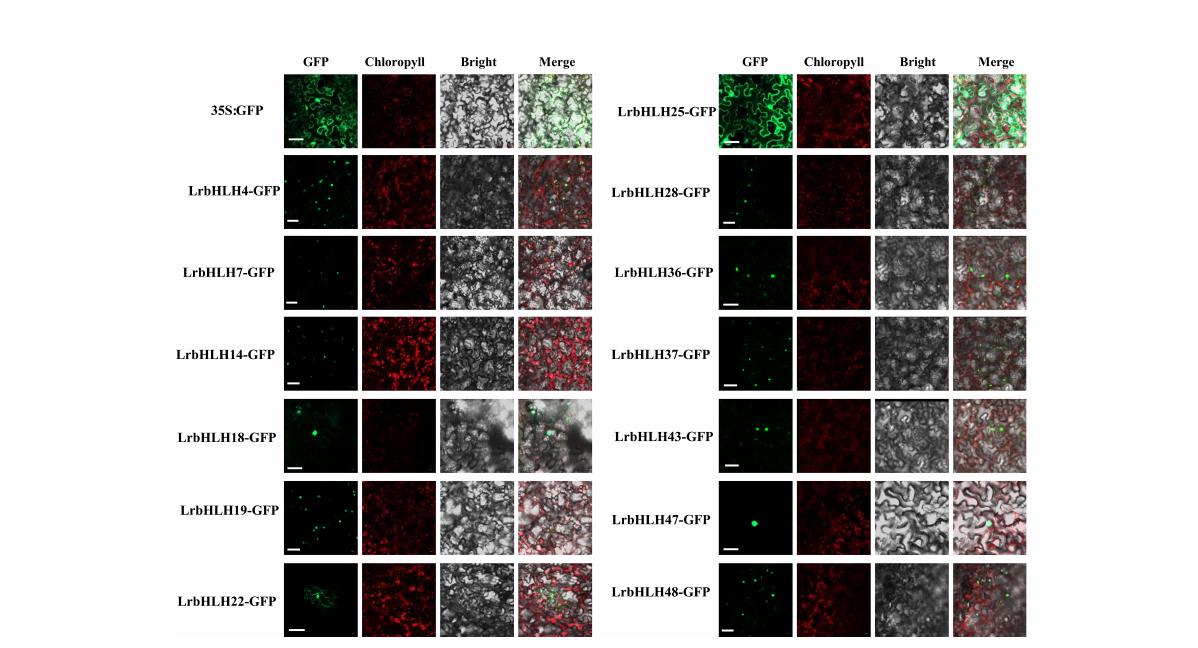
FIGURE 5 Subcellular localization of 15 LrbHLHs with GFP as a control, which was transiently expressed in N. benthamiana leaves. The photographs were taken using the green channel (GFP fl uorescence), red channel (Chlorophyll represents chlorophyll auto fl uorescence), bright channel, and their combination under a confocal microscope. Scale bar = 10